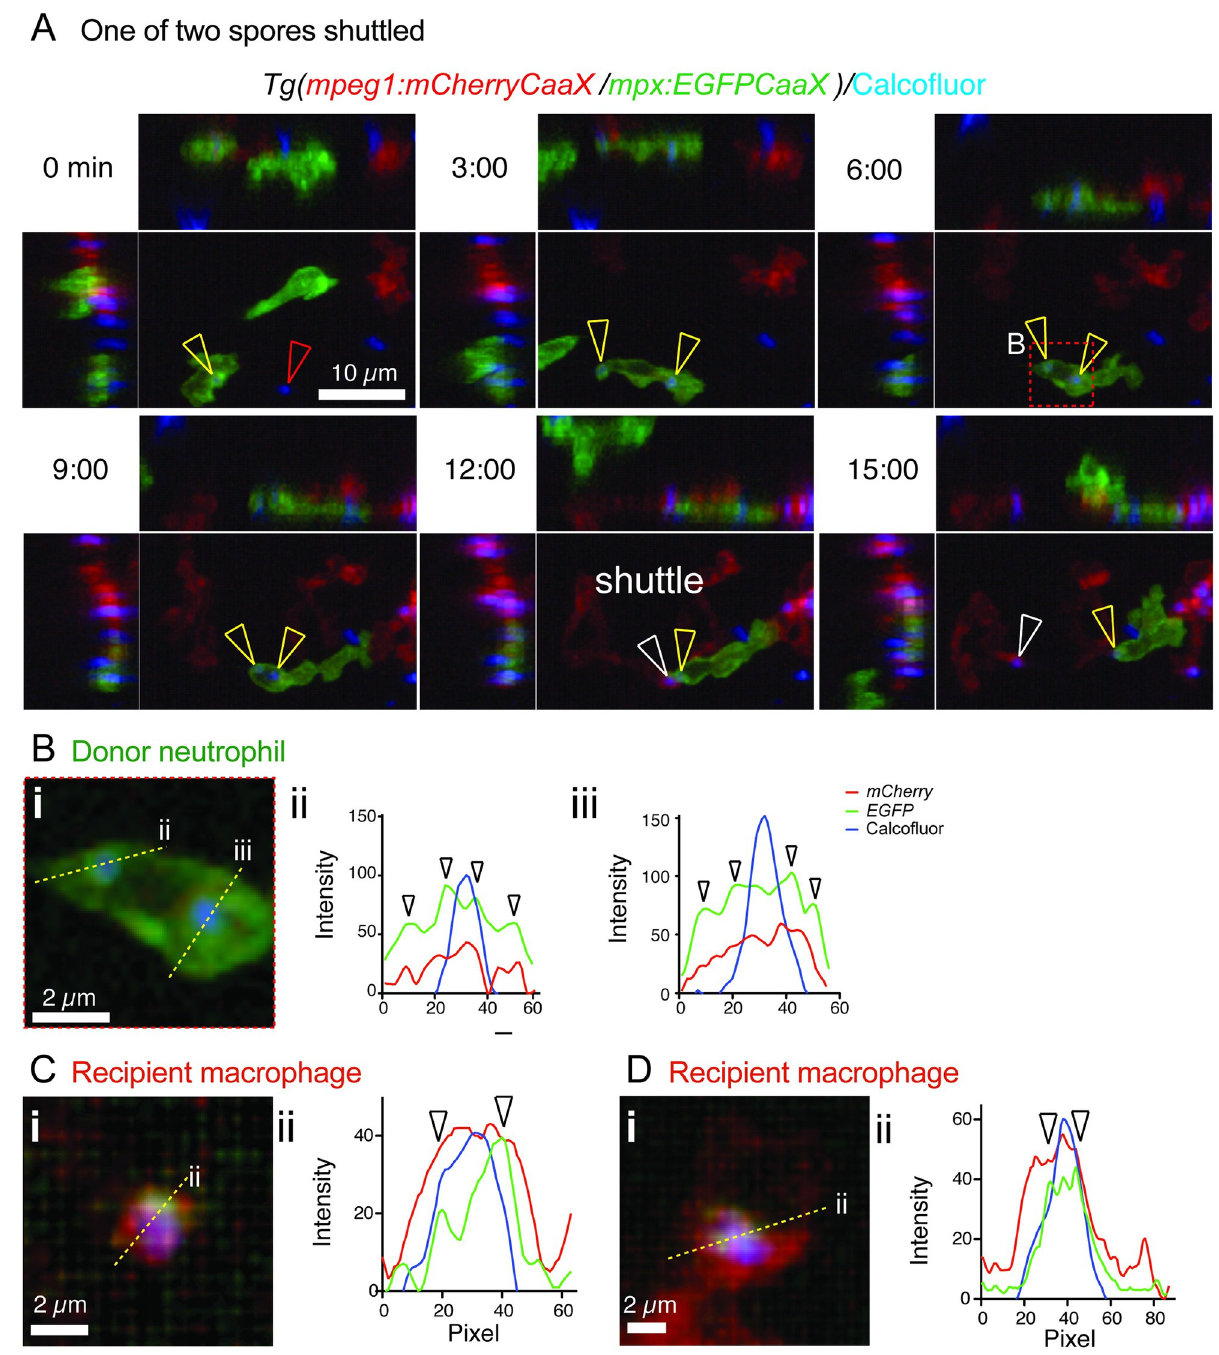
Fig 3. Shuttling of T . marneffei conidia between neutrophils and macrophages involves phagosome transfer. (A) Shuttle of calcofluor-stained conidium (blue) from Tg(mpx : EGFP-CaaX) neutrophils (green) to Tg(mpeg1 : mCherry-CaaX) macrophages (red). These reporter lines have membrane- localized fluorophore expression. Panels include isometric orthogonal yz and xz views corresponding to the xy maximal intensity projection and indicate the time in min from start of the movie. Colored arrowheads indicate a conidium before it is phagocytosed by the donor neutrophil (red), conidia within the donor neutrophil (yellow), and the conidium at the point of intercellular transfer and within the recipient macrophage (white). (Bi) Detail of the boxed area of the donor neutrophil in (A), 6-min panel. Yellow dotted line indicates the position of the cross-section for the 3-color fluorescence intensity plots in (ii) and (iii). Both shuttled and nonshuttled conidia are flanked by peaks of green fluorescence, consistent with their location in a membrane-lined phagosome. (C,D) Cross-sections fluorescence intensity profiles (ii) corresponding to the yellow lines in (i) for 2 macrophages that received a spore from a neutrophil in this dataset, which contained 3 independent spore shuttles. The arrowed EGFP-channel signal